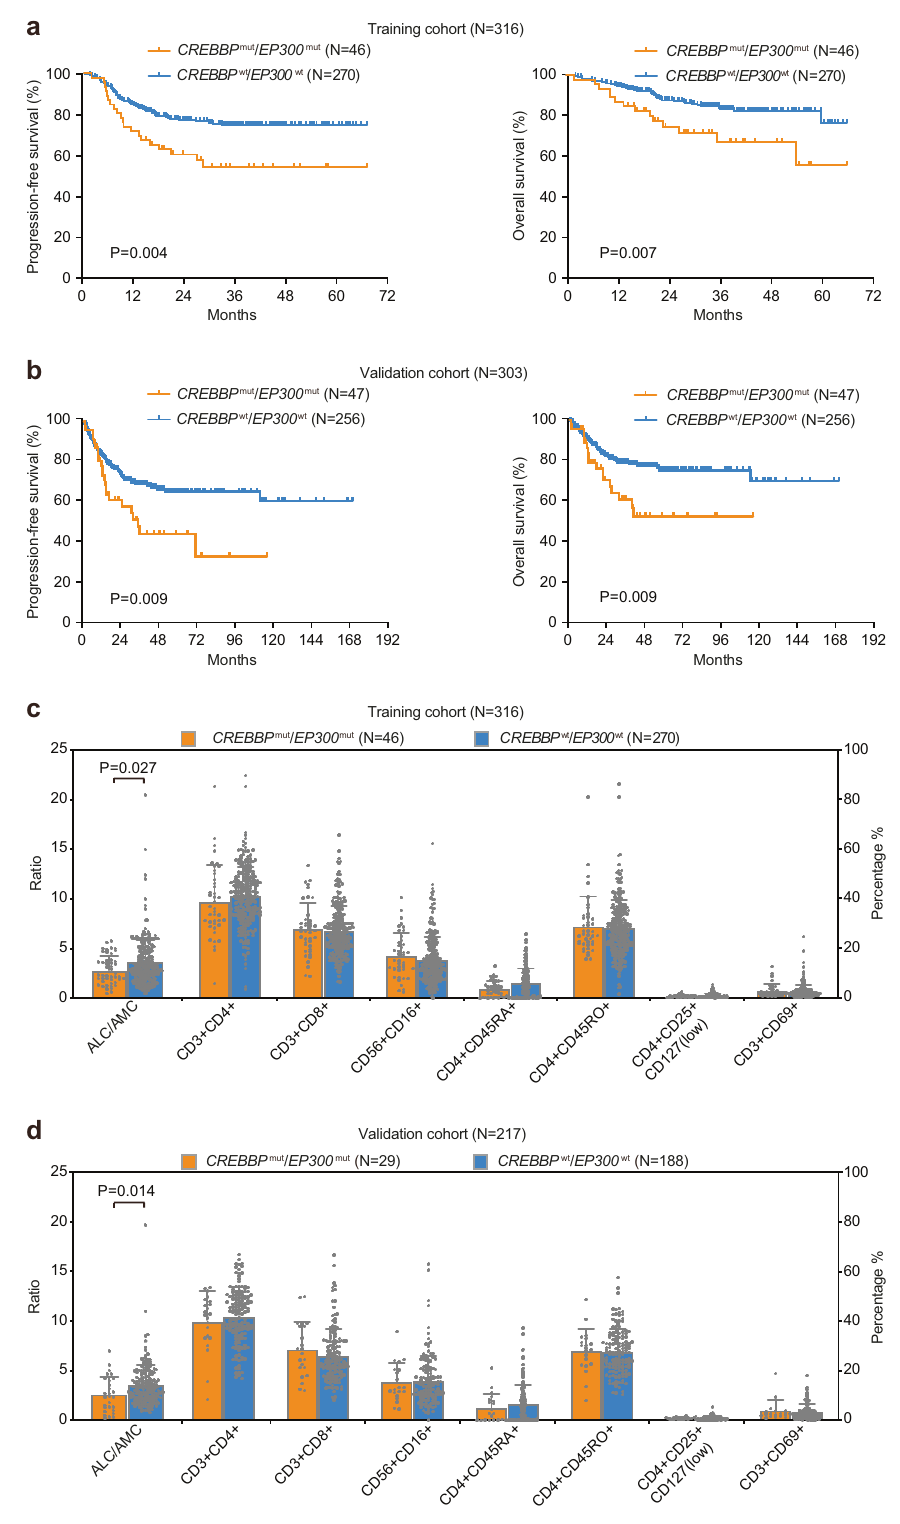
Fig. 2 CREBBP/EP300 mutations were related to tumor progression and the aberrant tumor microenvironment in diffuse large B-cell lymphoma (DLBCL). a , b Progression-free survival (PFS) and overall survival (OS) curves of DLBCL patients in the training cohort ( a ) and in the validation cohort ( b ). c , d The distribution of absolute lymphocyte-to-monocyte ratios (ALC/AMC) and T-cell subsets in terms of CREBBP / EP300 mutation status in the training cohort ( c ) and in the validation cohort ( d ). Data are presented as the mean ±